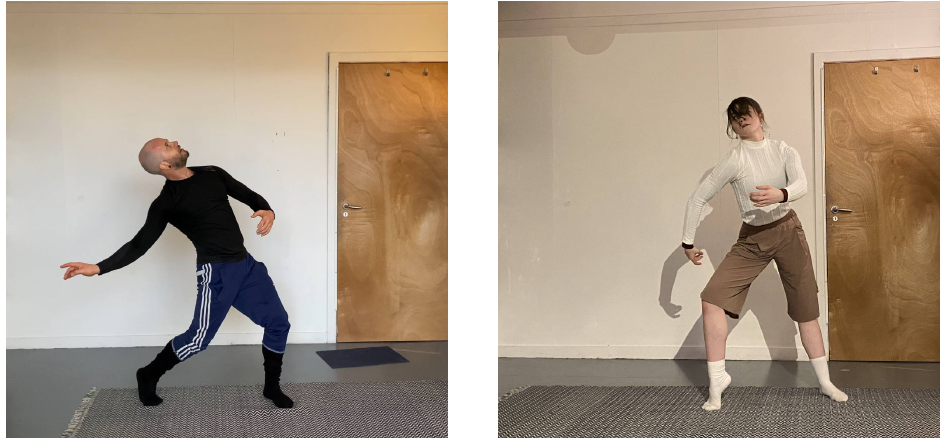
Figure 5. Dancers Divine Tasinda, Adilso Machado and Catriona Robertson improvising with the Sonified Body system during the exploratory